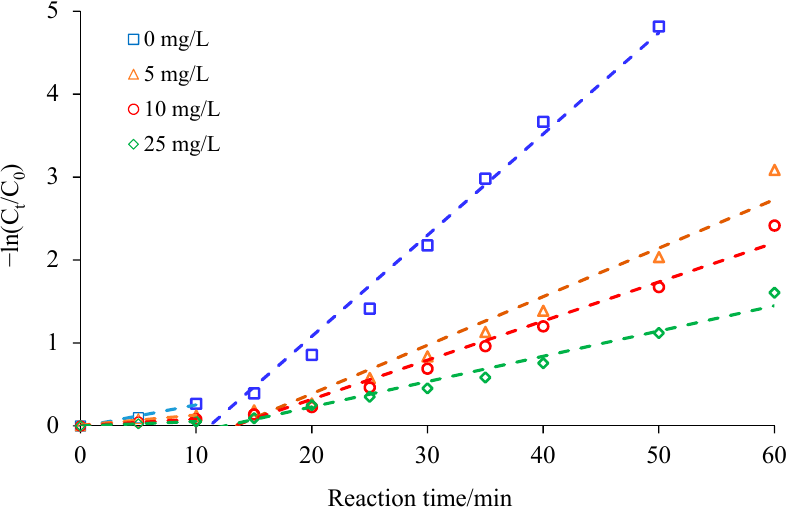
Figure 11. Effect of humic acid on CCl 4 degradation by Ag/Fe particles. Reaction conditions were: humic acid concentrations of 5, 10 and 25 mg/L, 0.4 wt.% Ag/Fe dosage of 20 g/L, CCl 4 initial concentration of 20 mg/L, initial solution pH of 7, stirring rate of 200 rpm. C 0 is the initial CCl 4 concentration, and C t is the CCl 4 concentration at time t.